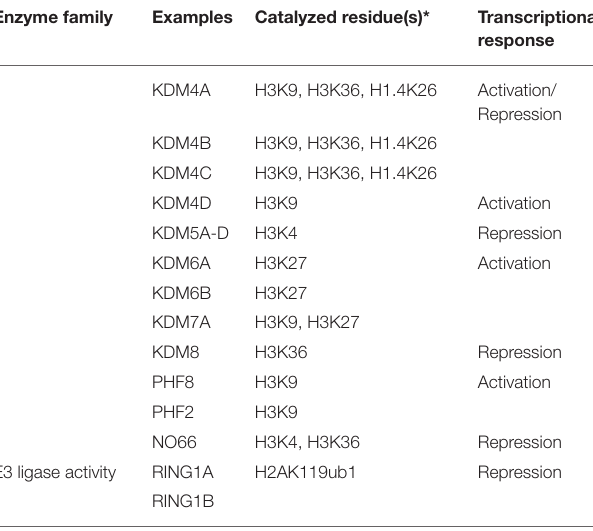
TABLE 1 | Enzymes mediating epigenetic modifications. Enzyme family Examples Catalyzed residue(s)* Transcriptional